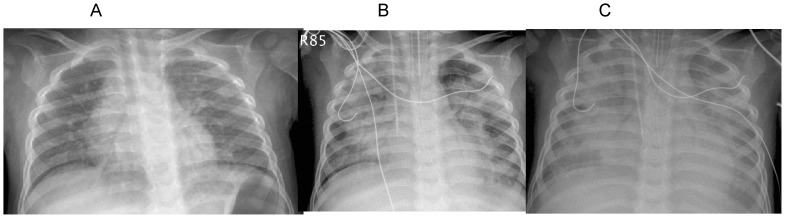
Serial chest radiographs of a 2 year-old boy: 2A shows bilaterally increased infiltration on Day 1 after onset, 2B reveals bilateral patch consolidation on Day 5, and 2C almost complete whiteout of bilateral lungs.